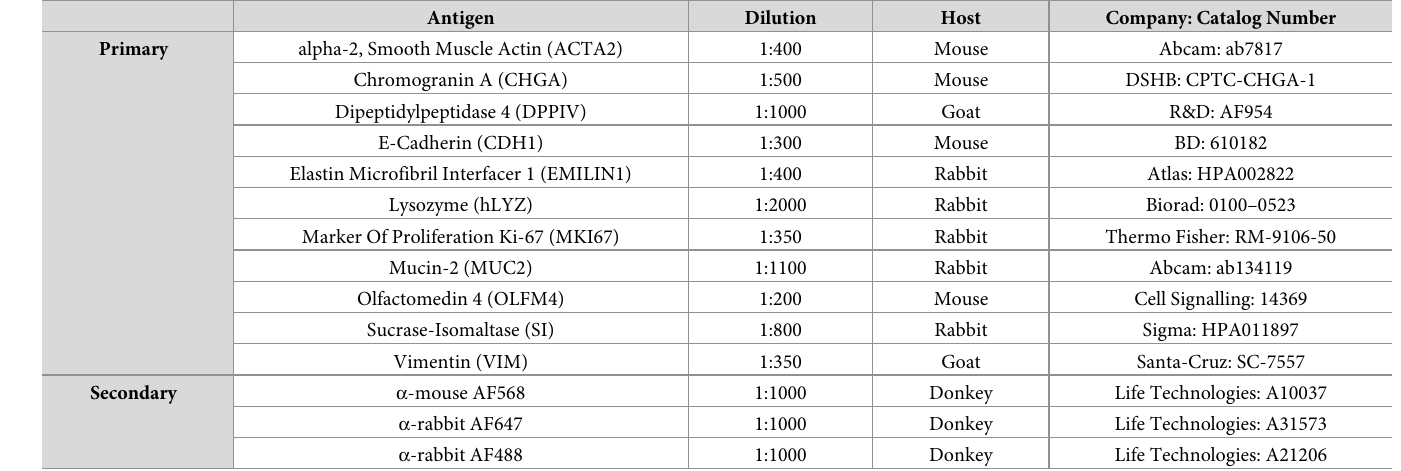
Table 1. Antibody information for immunofluorescence staining.